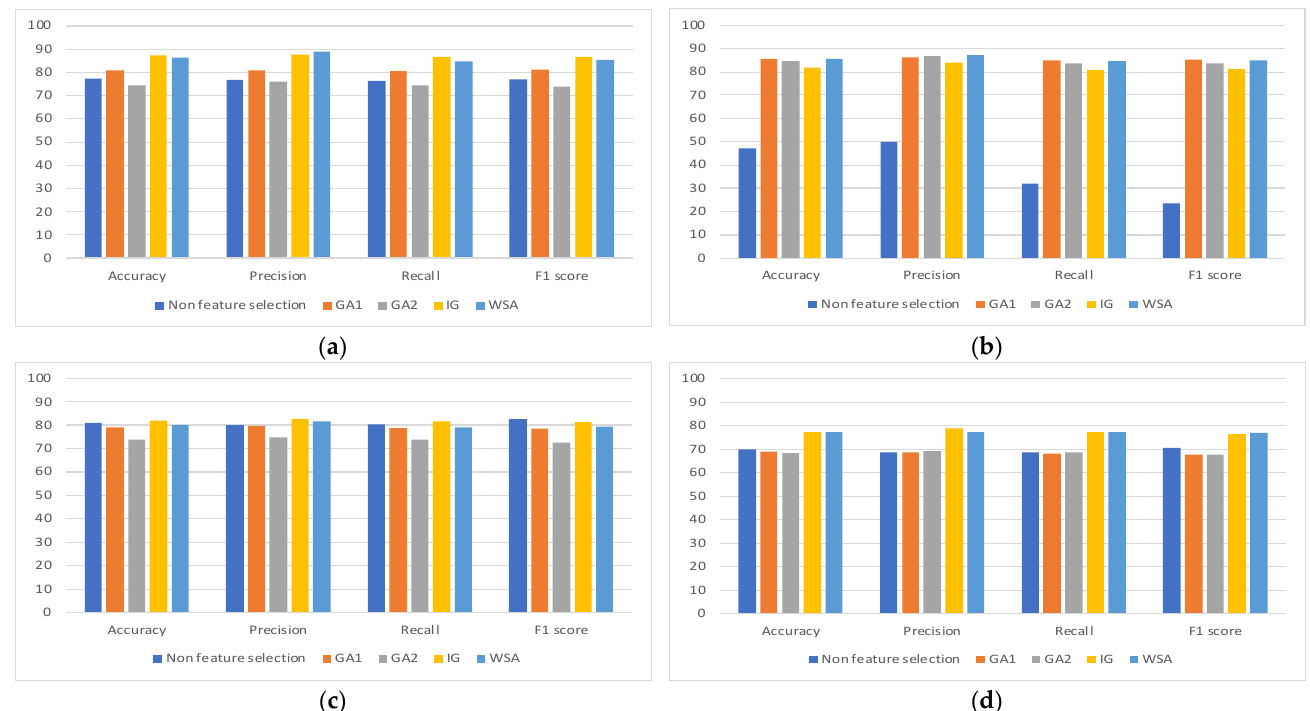
Figure 4. Graph comparing the four performance indicators of feature selection methods: ( a ) XGBoost; ( b ) DNN; ( c ) SVM; and ( d ) DT.